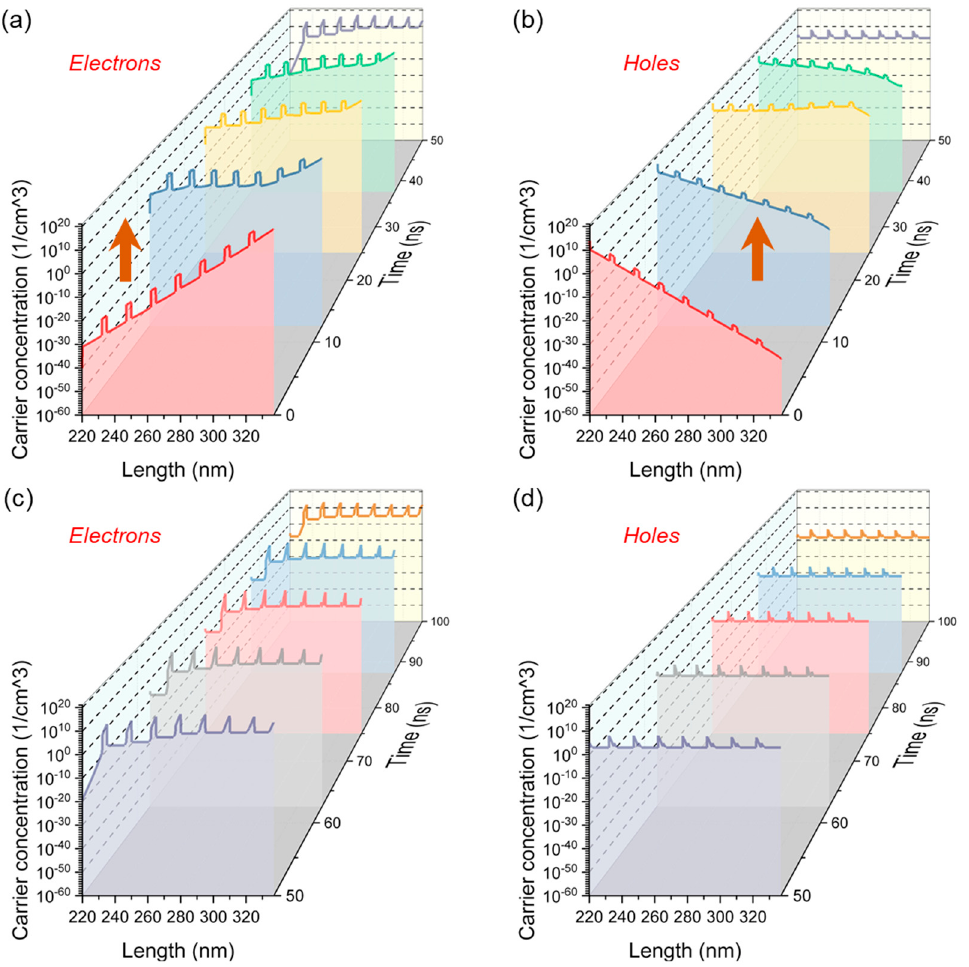
Figure 7. Variation of the carrier concentration in MQW region. ( a ) Electron concentration in the positive half cycle. ( b ) Hole concentration in the positive half cycle. ( c ) Electron concentration in the negative half cycle. ( d ) Hole concentration in the negative half cycle.